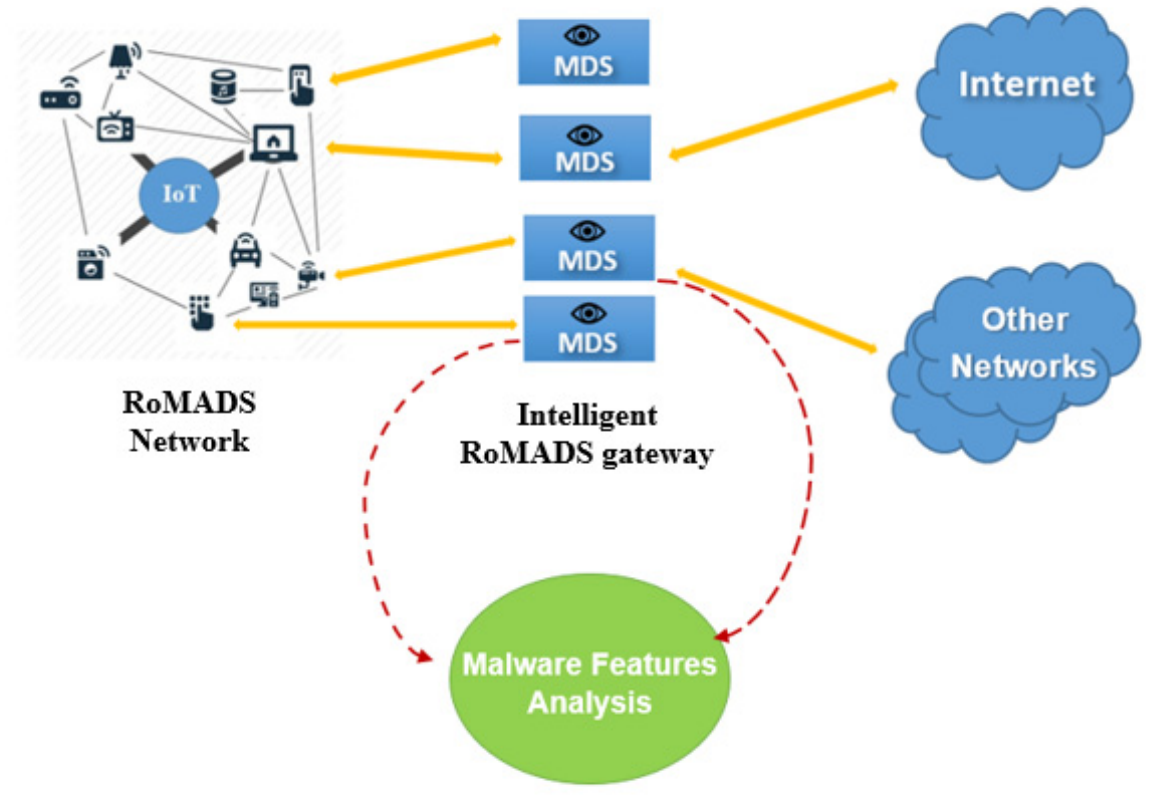
Figure 15. Malware features analysis.